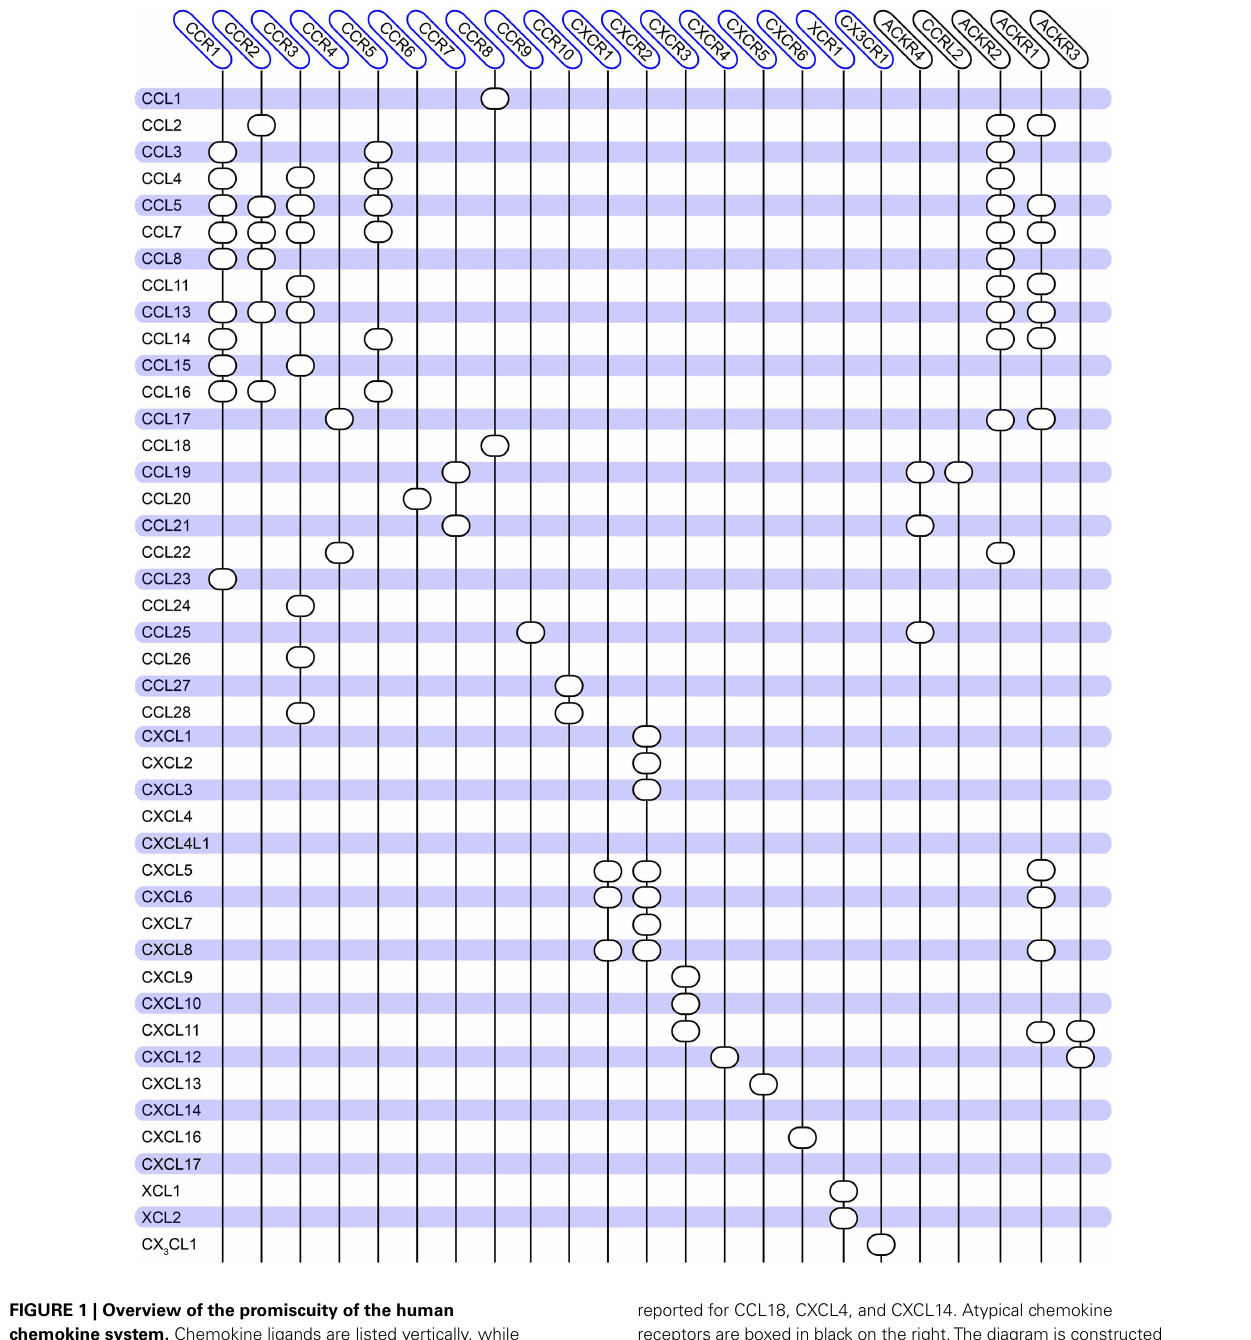
FIGURE 1 | Overview of the promiscuity of the human chemokine system. Chemokine ligands are listed vertically, while chemokine receptors are listed horizontally. A circle indicates interaction between the receptor and ligand. No receptors are